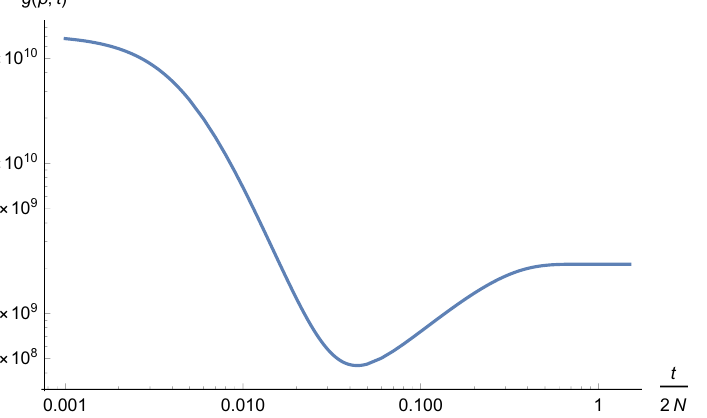
Figure 1. Plot of the exact spectral form factor g ( (cid:12); t ) in GUE for (cid:12) = 5 ; N = 500.